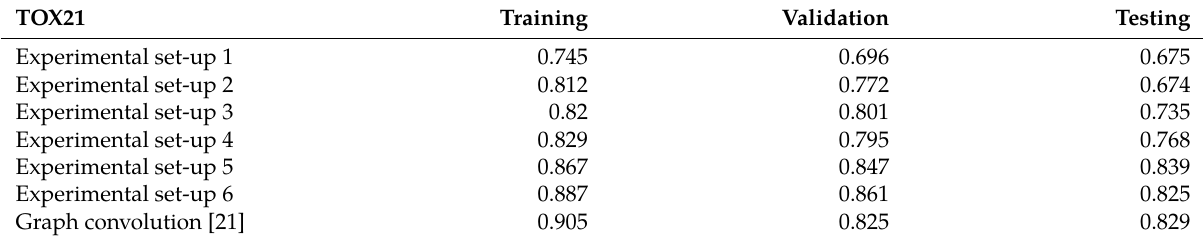
Table 2: Results for the TOX21